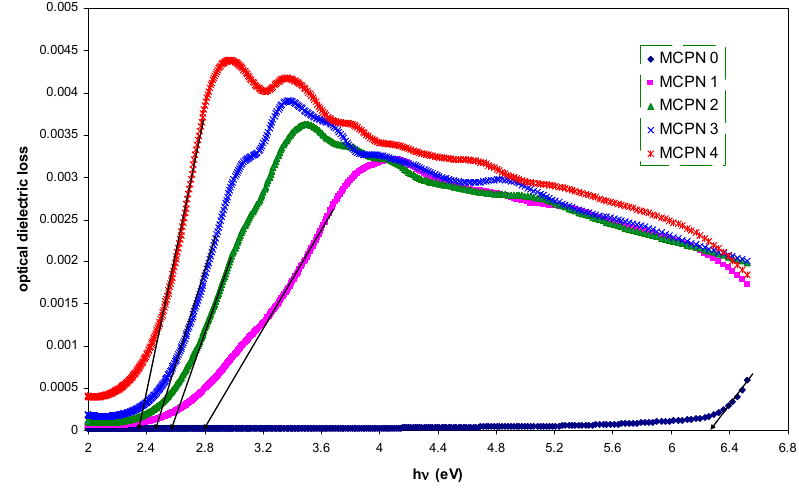
Figure 7. Optical dielectric loss versus photon energy (h υ ) for pure MC and doped MC samples.